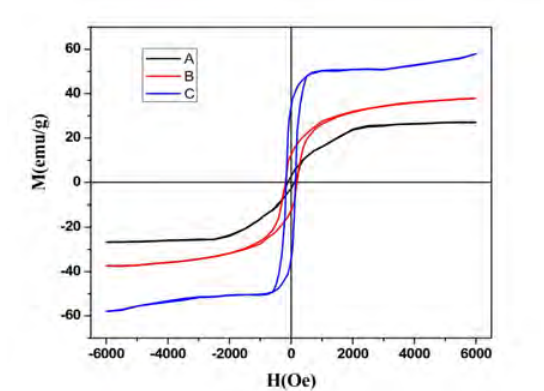
Fig. 6. Magnetic hysteresis loop for Ni-Co/Cu multilayer samples; A) Ni-Co(3nm)/Cu(3nm), B) Ni- Co(3nm)/Cu(2nm), C) Ni-Co(3nm)/Cu(1nm).